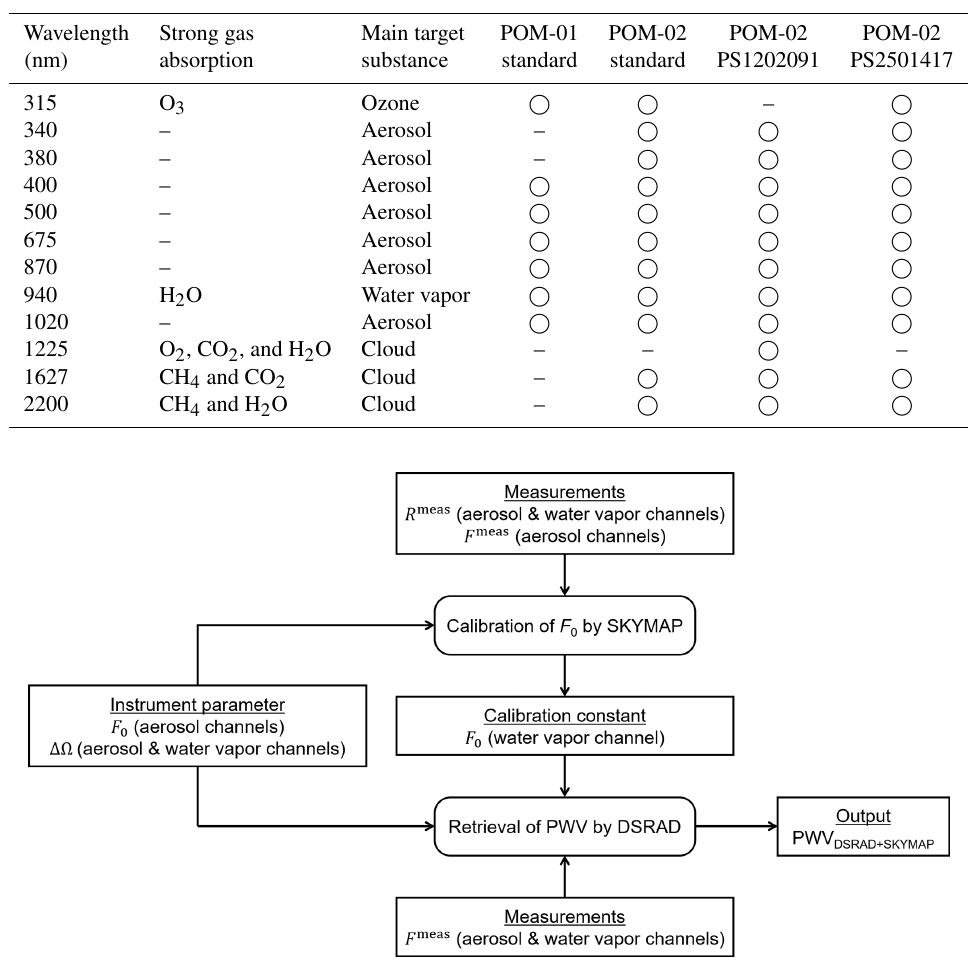
Figure 1. Diagram of the on-site self-calibration method (SKYMAP) and retrieval of PWV from direct solar irradiances (DSRAD). Square boxes show the operation of the calculation and input–output parameters, and rounded boxes show the operation of the algorithm.